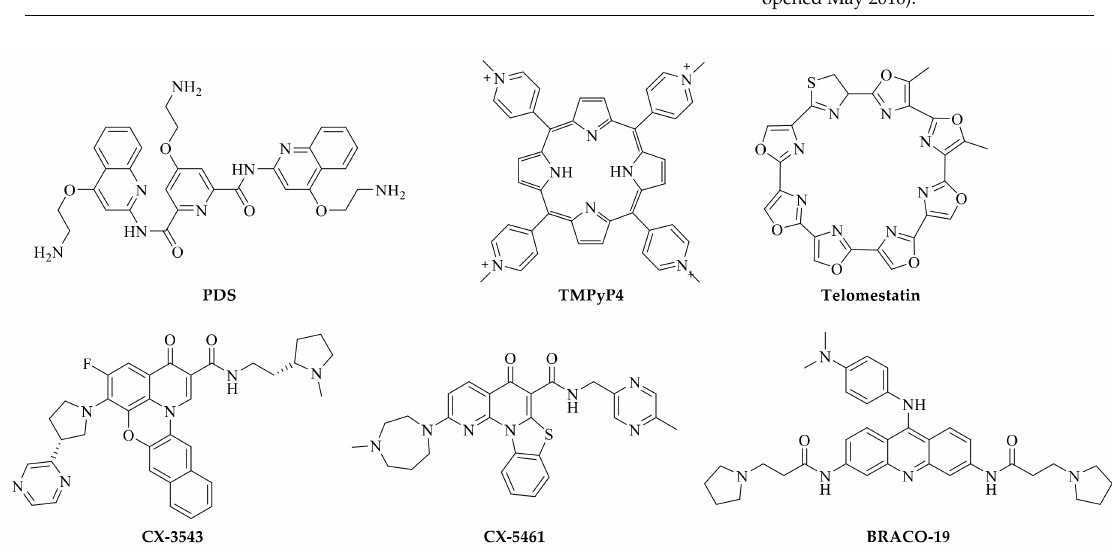
Figure 4. Structures of typical G-quadruplex ligands in this review, including BRACO-19, TMPyP4, Telomestatin, CX3543, CX5461, and pyridostatin